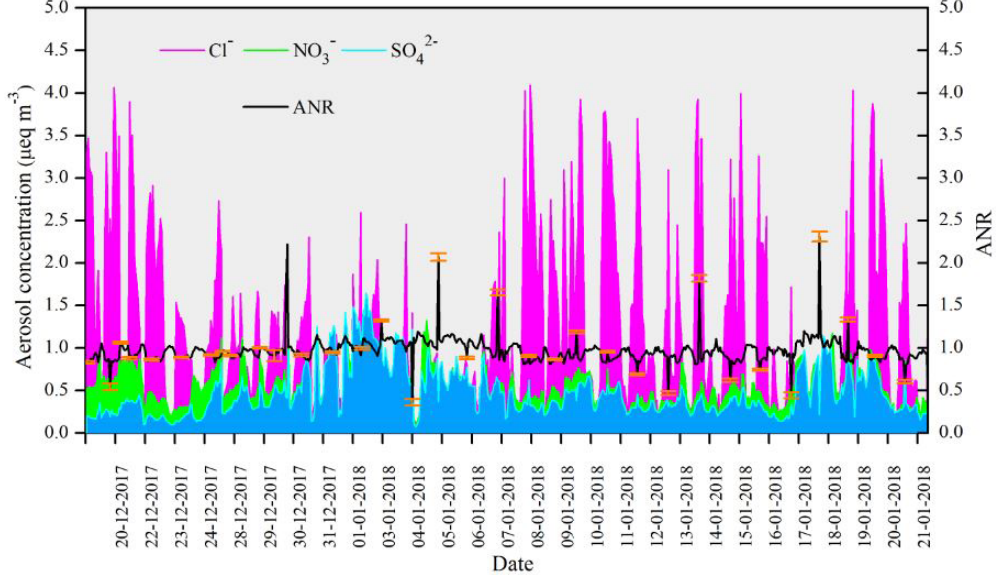
− , and SO 2 − as the anions (µeqm − 3 ) and aerosol neutralization ratio (ANR), where ANR > 1 3 4